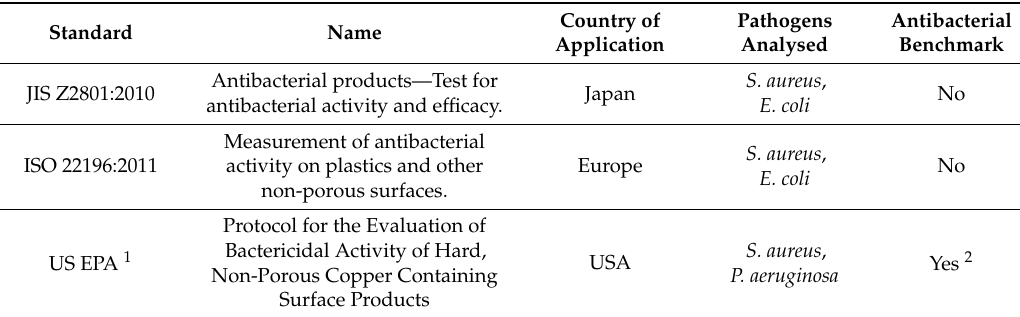
Table 1. Summary of antimicrobial testing